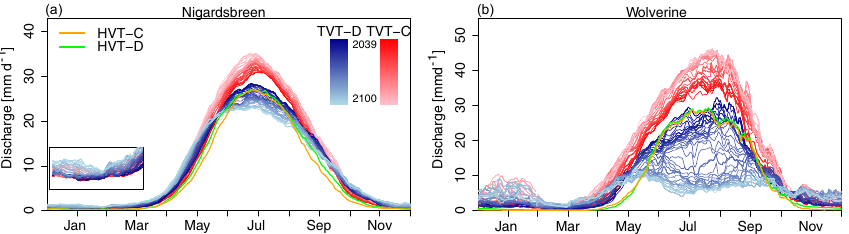
Figure 7. Drought thresholds for the four different scenarios (HVT-C, HVT-D, TVT-C and TVT-D). The colour gradient for both transient thresholds (blue and red) indicates the adaptation of the threshold each year (for 2039–2100). The thresholds are shown for the Nigardsbreen (a) and Wolverine (b) catchments for climate scenario RCP4.5. The inset in panel (a) zooms in to the low flow period of